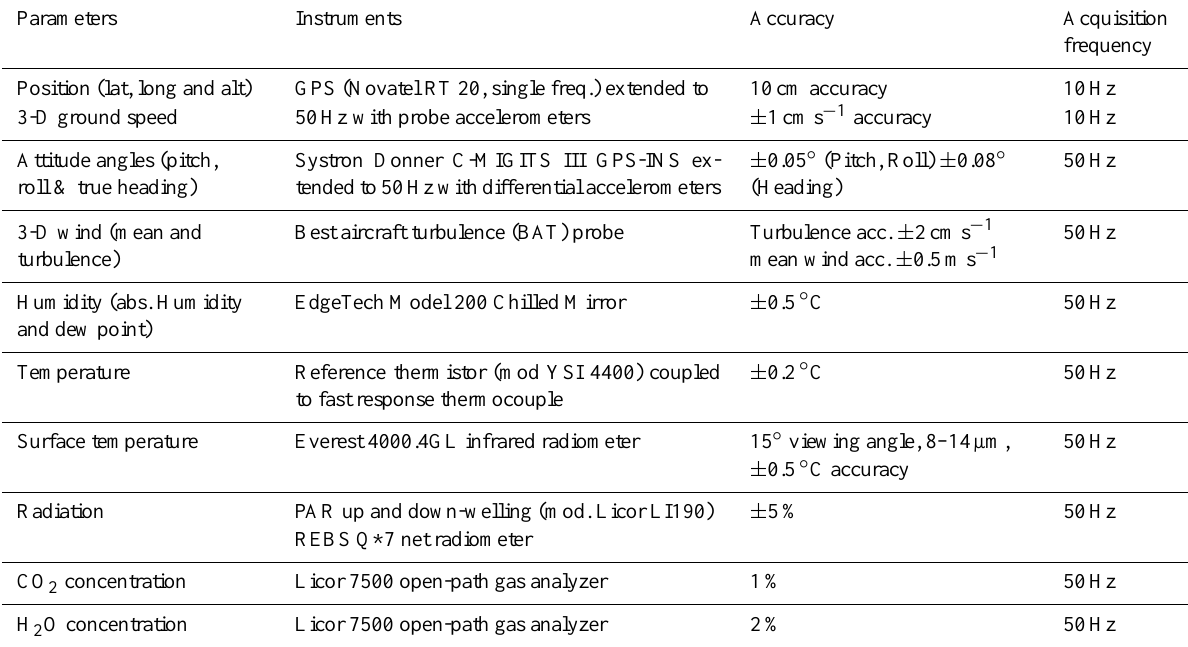
Table A4. Instrumentation of the Sky Arrow